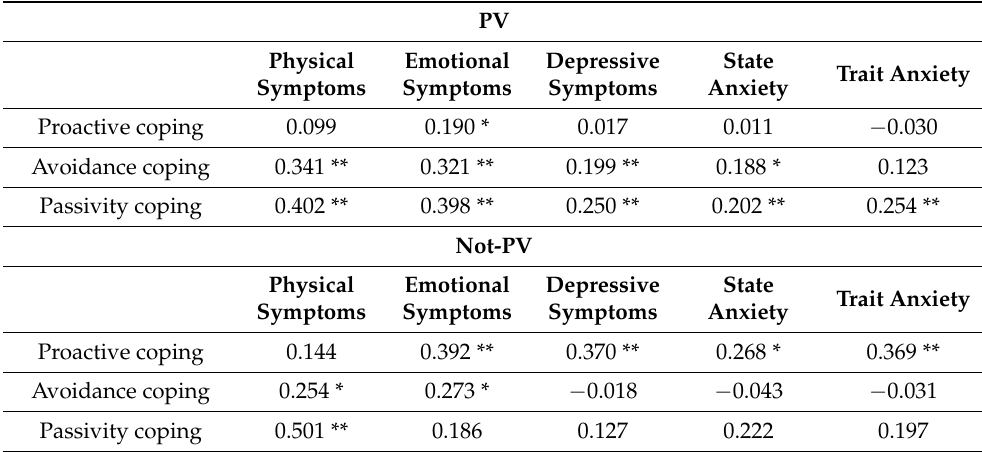
Table 4. Correlational analysis in PV and